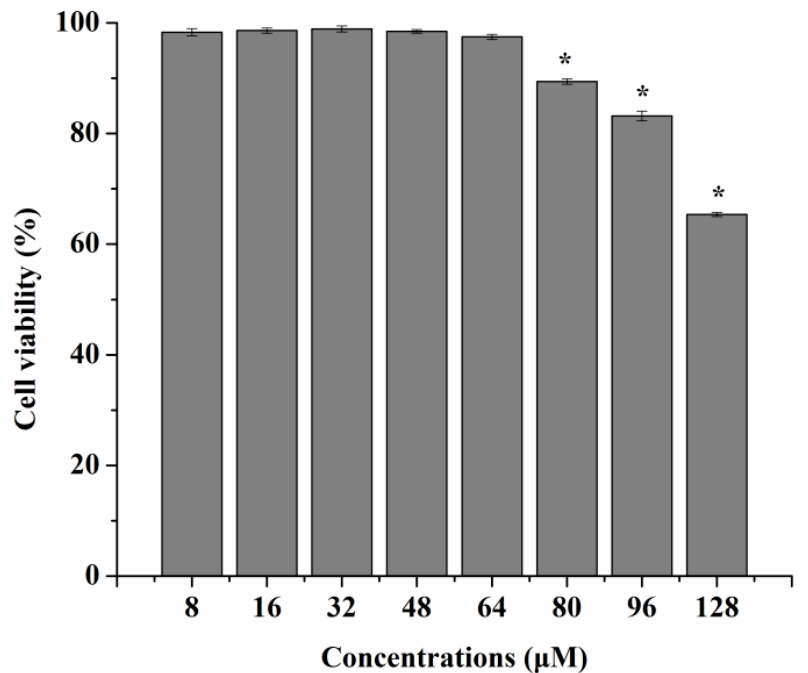
Figure 5. In vitro cytotoxicities of curcumin solutions at different concentrations ranging from 8 to 128 μ M. When concentrations of curcumin solutions were in the range of 8–64 μ M, the cell viability was not affected at all (mean ± SD, n = 3) (* p < 0.05, compared with curcumin solutions at 64 μ M).